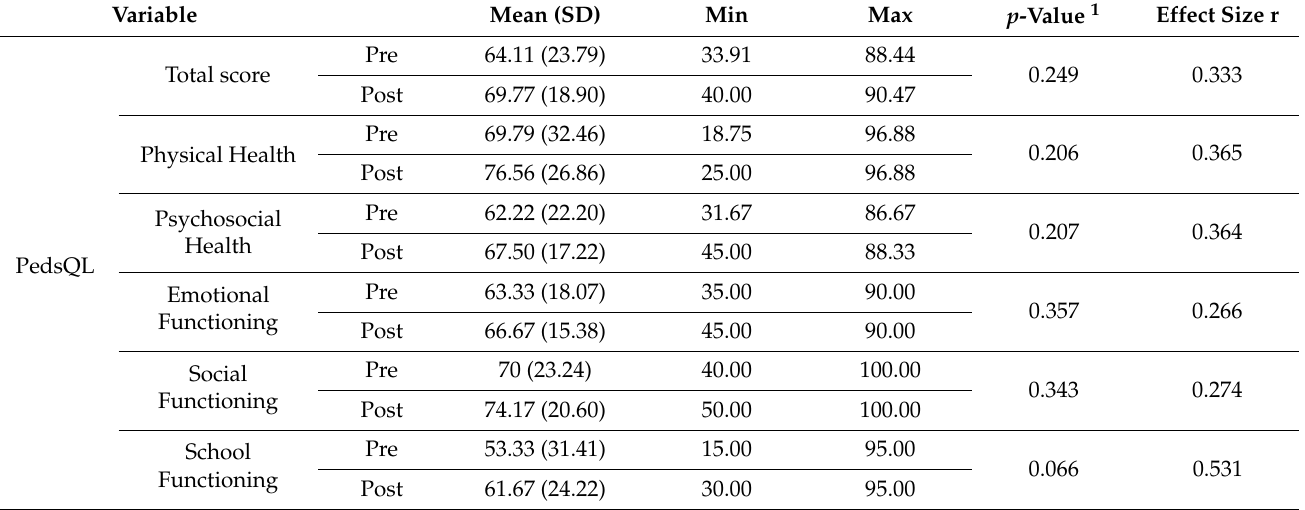
Table 2. Results of quantitative evaluation of the WST intervention for children with Autism Spectrum Disorder ( n = 6). Variable Mean (SD)